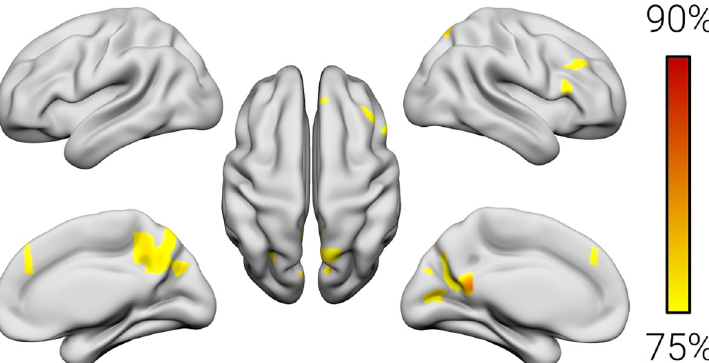
Fig 2. Network-level functional classification results. The color bar indicates the peak accuracy for the classification of children with dyscalculia versus typical controls ( P < 0.001, corrected by permutation testing) based on whole-brain functional connectivity (degree centrality). The numerical data used in this figure are included in S2 Data.